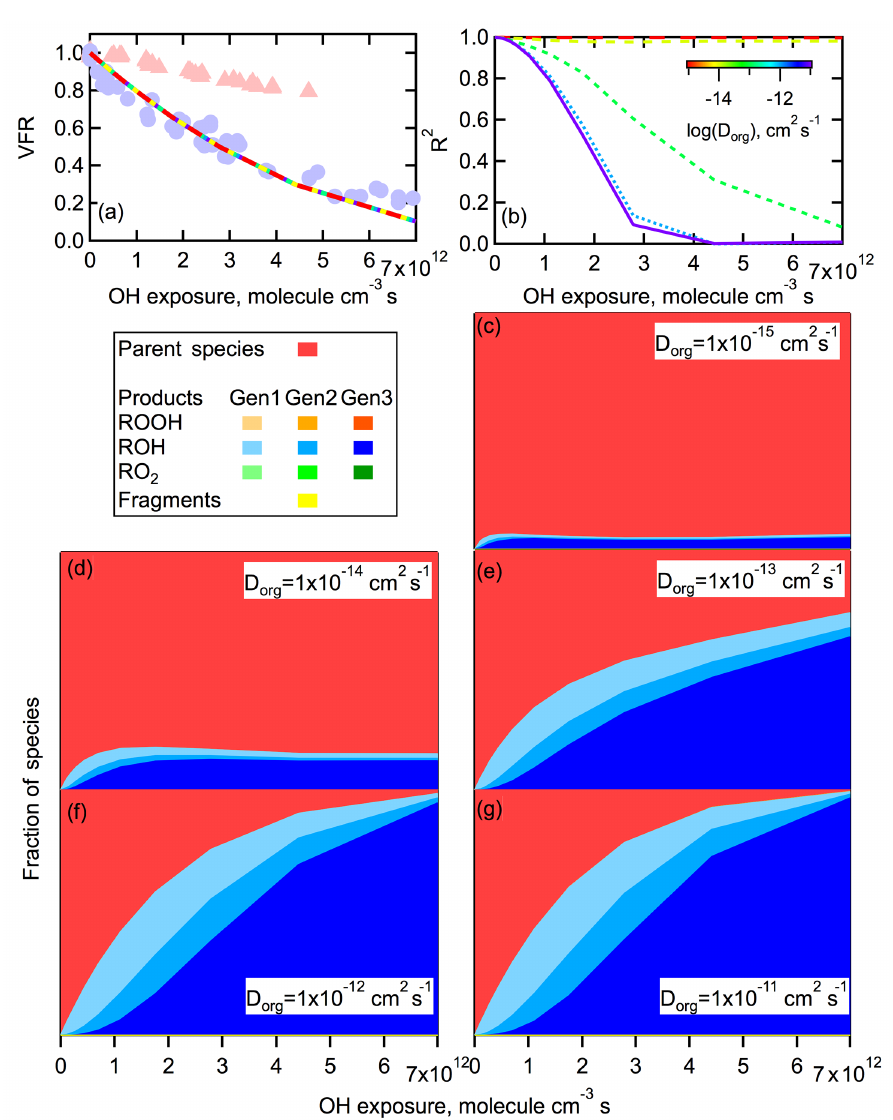
Figure 10. Simulated effect of variations in the diffusion coefficient on mass loss and compositional change. For these simulations, the D org is allowed to vary from 10 − 11 to 10 − 15 cm 2 s − 1 while all other parameters are held constant and chosen to give good agreement with the high-RH observations ( γ = 0 . 50, p frag = 0 . 31). (a) The simulated volume fraction remaining (VFR) versus OH exposure. Observations (symbols) are shown for reference for low-RH (red triangles) and high-RH (blue circles) conditions. The simulation results overlap because diffusivity has no effect on bulk mass loss. (b) The calculated coefficient of determination ( R 2 ) between the molecular density of all simulated species as a function of OH exposure, referenced to the nonoxidized case. The D org is indicated by the line color, with the purple solid line denoting the fastest diffusion. (c–g) Simulated fractional concentrations of each species as a function of OH exposure for different D org values. Colors indicate different species and generation (see legend). Only the ROH species are readily